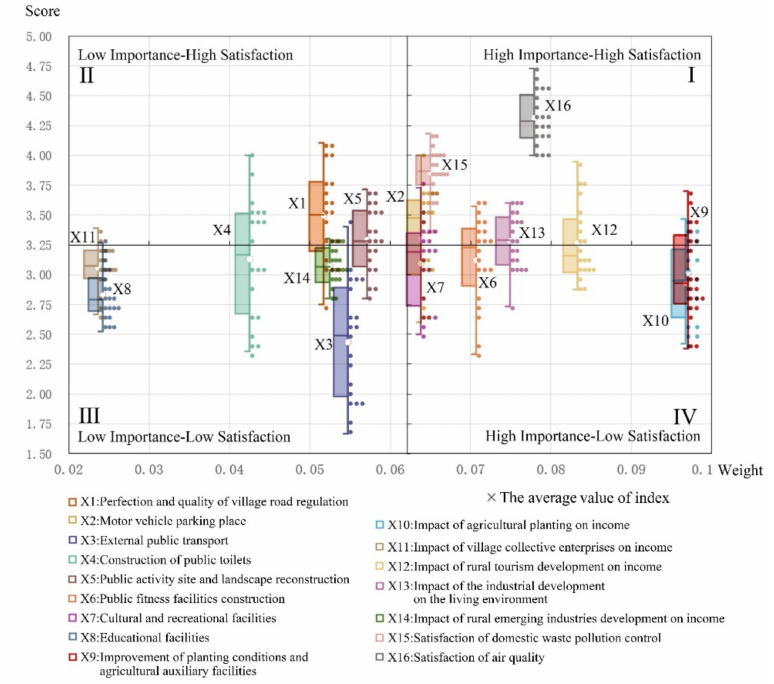
Figure 4. Evaluation of satisfaction and importance factor